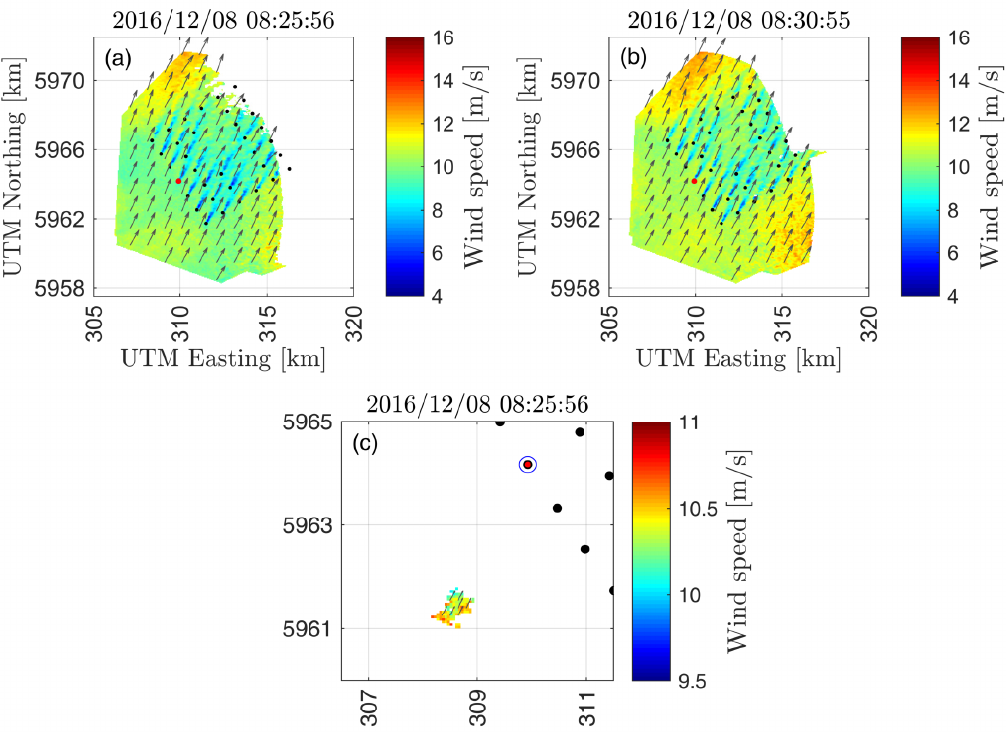
Figure 5. Wind speed forecast for WT 4 (marked in red). ( a ) Dual-Doppler flow field at the time that the forecast is issued and ( b ) validated; ( c ) cloud of wind vectors used to derive the probabilistic forecast for WT 4 and the respective area of influence (blue circle). Notice the different scales on Figure